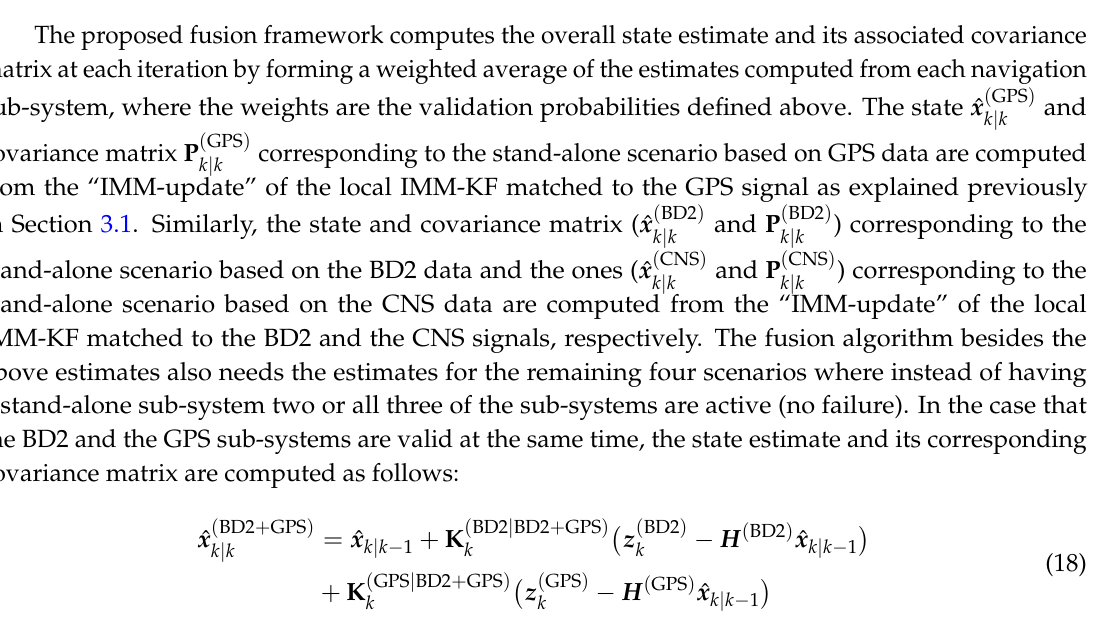
Figure 6. ( a ) Measurement probability of validity; ( b ) Probability